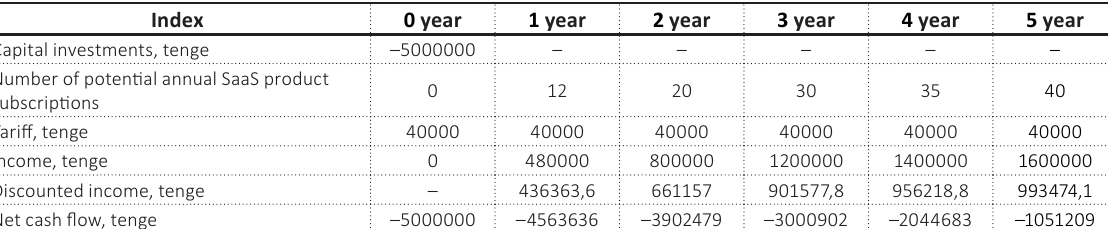
Table 7. Calculation of the payback period of the SaaS-product “3D-quarry” (the cost of an annual subscription is 40,000